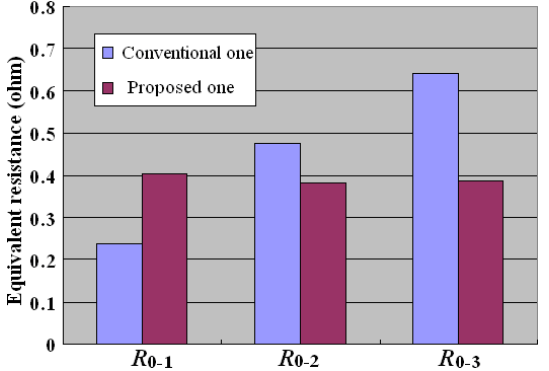
Figure 14. Measured equivalent resistances of the test systems of Figure 11b,c.